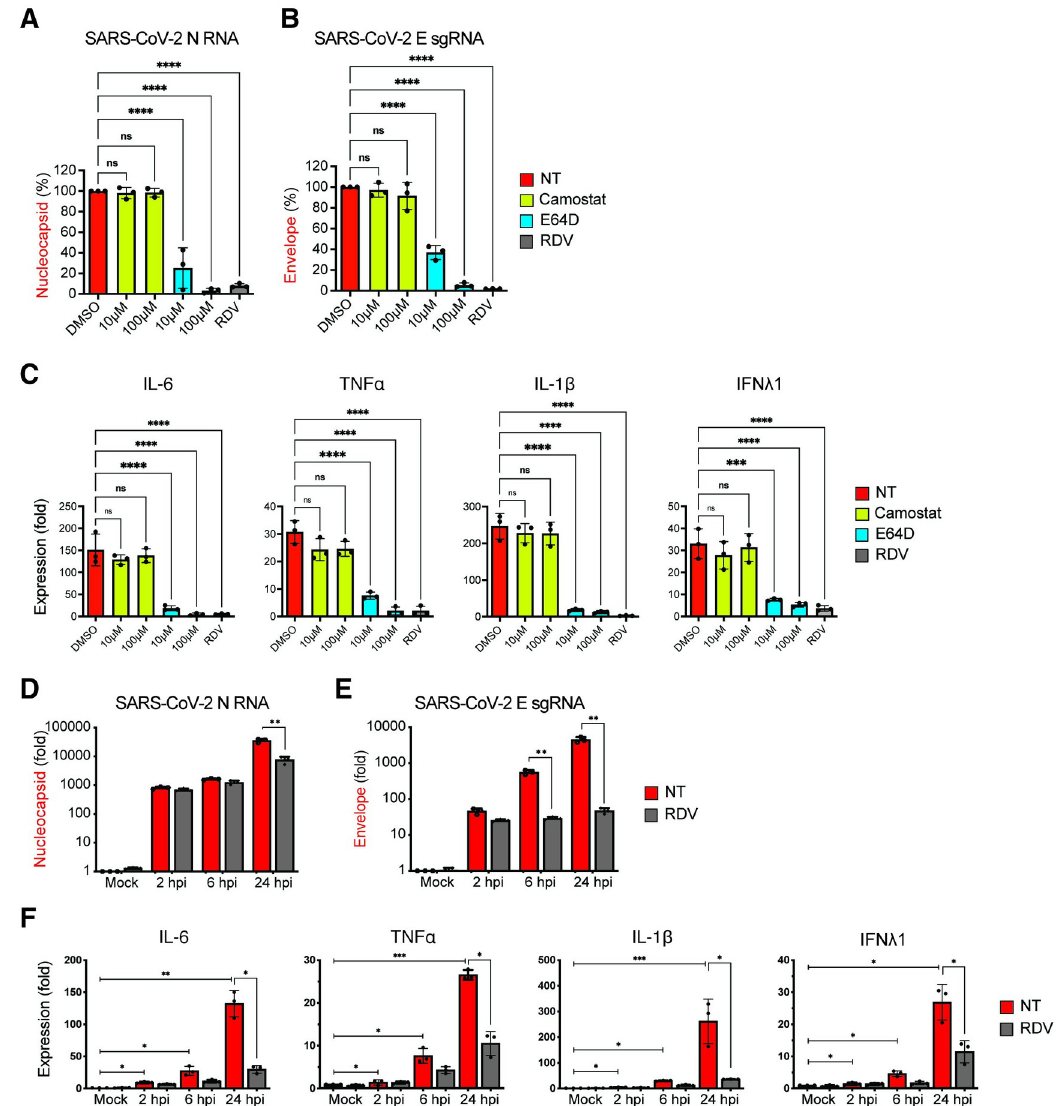
Fig 7. Endosomal entry of SARS-CoV-2 in MDMs facilitates restricted SARS-CoV-2 RNA synthesis and induction of pro- inflammatory cytokines. ( A - C ) MDMs from multiple donors were infected with SARS-CoV-2 (MOI = 1) in the absence or presence of camostat, E64D, or RDV (1 μ M). Cells were harvested at 24 hpi and total RNA analyzed by RT-qPCR for expression of viral N RNA ( A ) and envelope sgRNA ( B ). ( C ) Induction of proinflammatory cytokines normalized to mock (uninfected) control from each donor. ( D - F ) MDMs were infected with SARS-CoV-2 (MOI = 1), in the absence or presence of RDV (1 μ M), and viral replication kinetics analyzed by RT-qPCR at indicated timepoints for total N RNA ( D ) and E sgRNA ( E ). Induction of indicated cytokine mRNAs ( F ) normalized to mock from each donor. The means ± SEM are shown from 3 independent experiments, and each symbol represents an independent donor. Significant differences between conditions were determined by one-way ANOVA followed by the Dunnett’s post-test ( A - C ),or Tukey’s multiple comparisons test ( F ), comparing to DMSO-treated control. P - values: � < 0.1; �� < 0.01; ��� < 0.001; ���� < 0.0001; ns: not